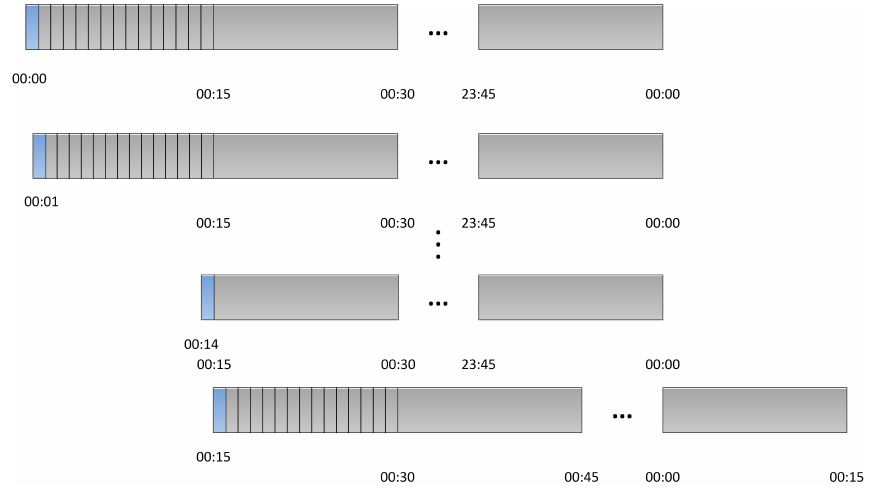
Figure 6. Temporal structure of the EMS due to the integration of the household electrical load